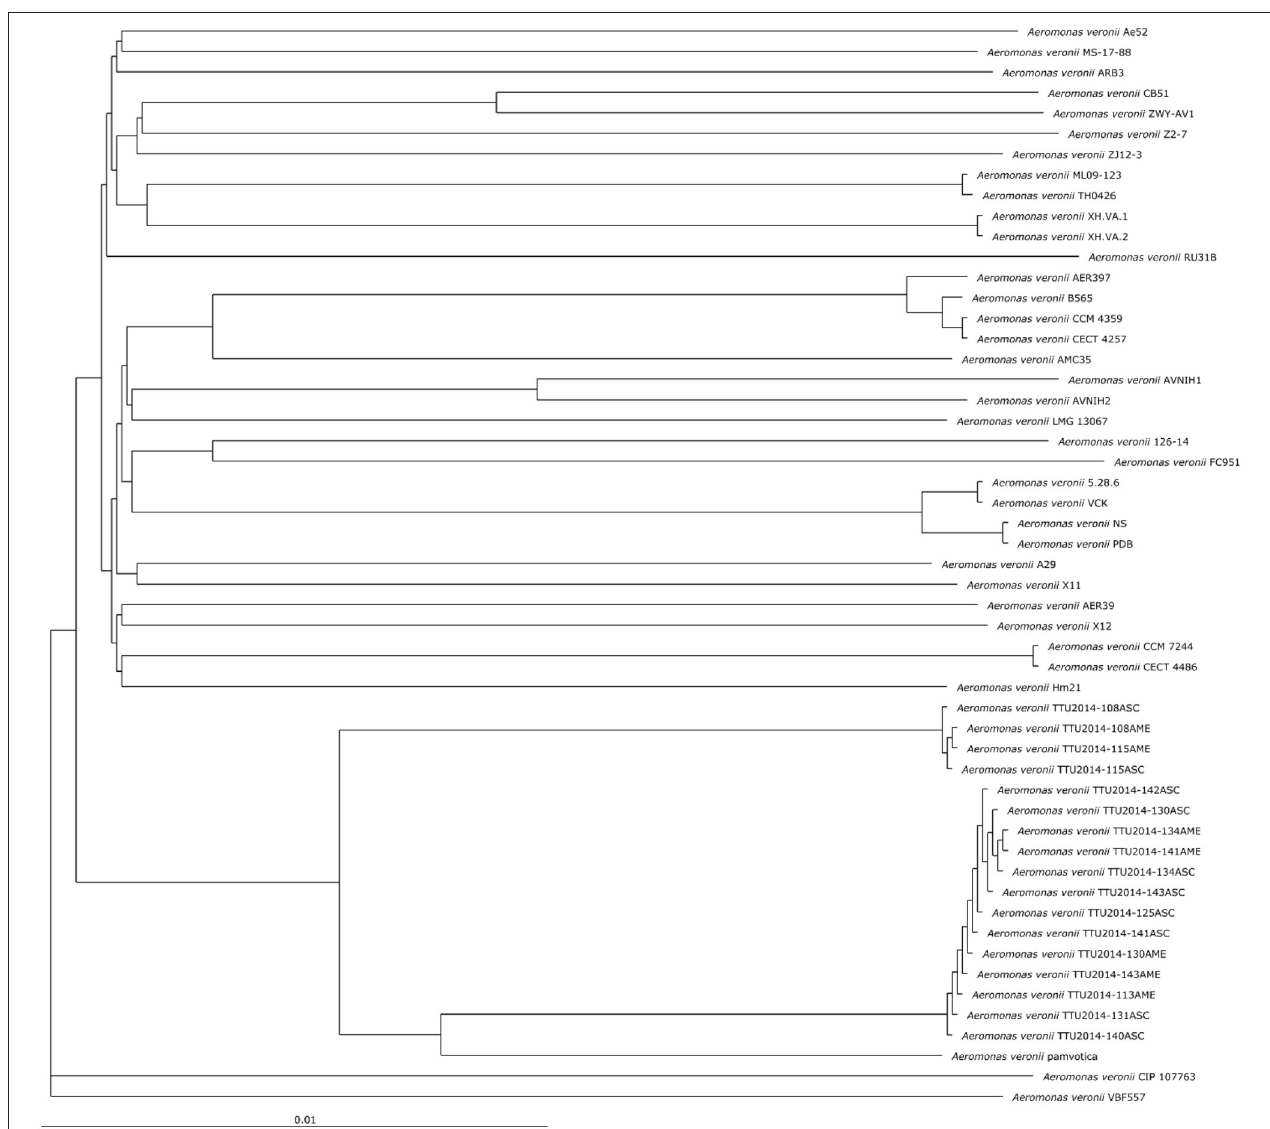
FIGURE 1 | Phylogenetic tree analysis based on the core genomes of A. veronii